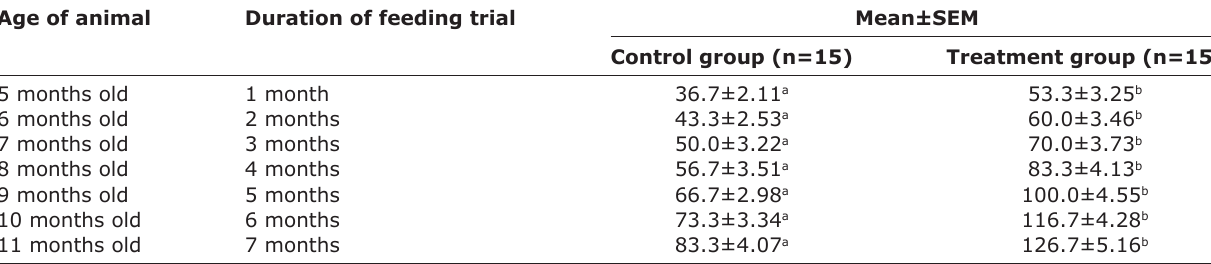
Table-5: The measurement of average daily gain in control and treatment groups throughout feeding trial. Age of animal Duration of feeding trial